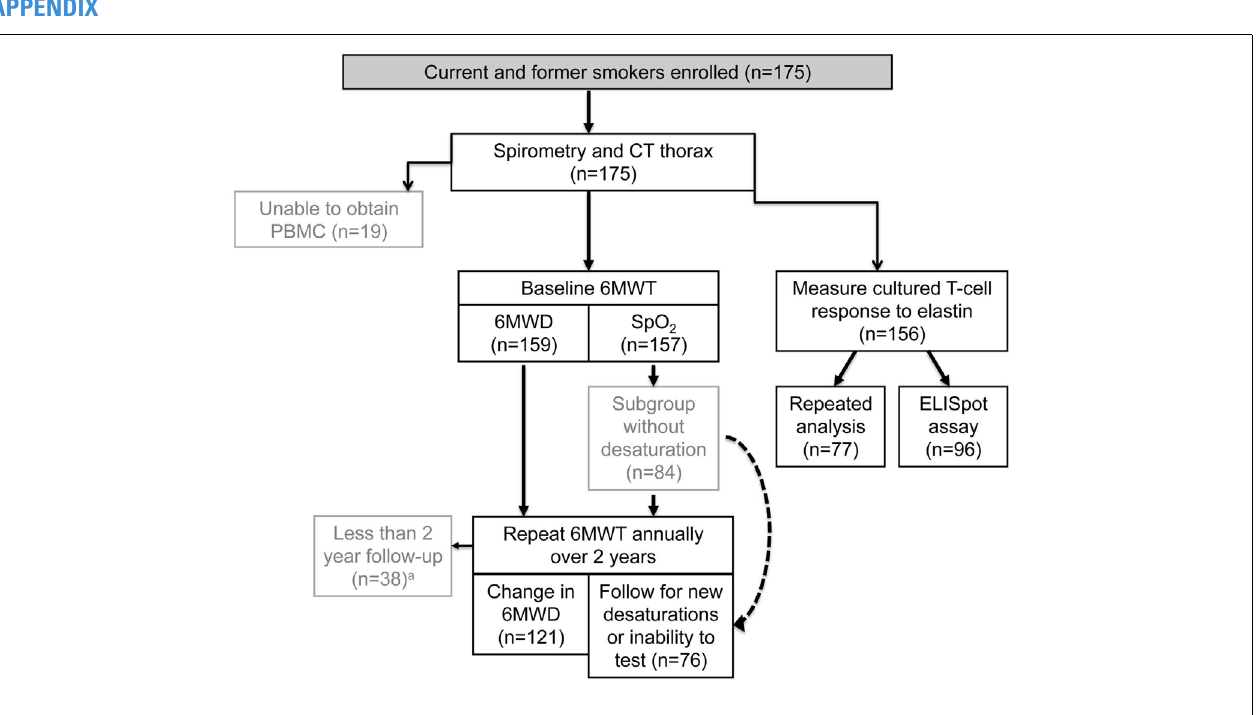
follow-up or withdrew consent, 9 did not have sufficient time from baseline to complete 2years, 8 due to illnesses other than respiratory health, 2 due to scheduling conflicts, 2 due to frequent respiratory exacerbations, 1